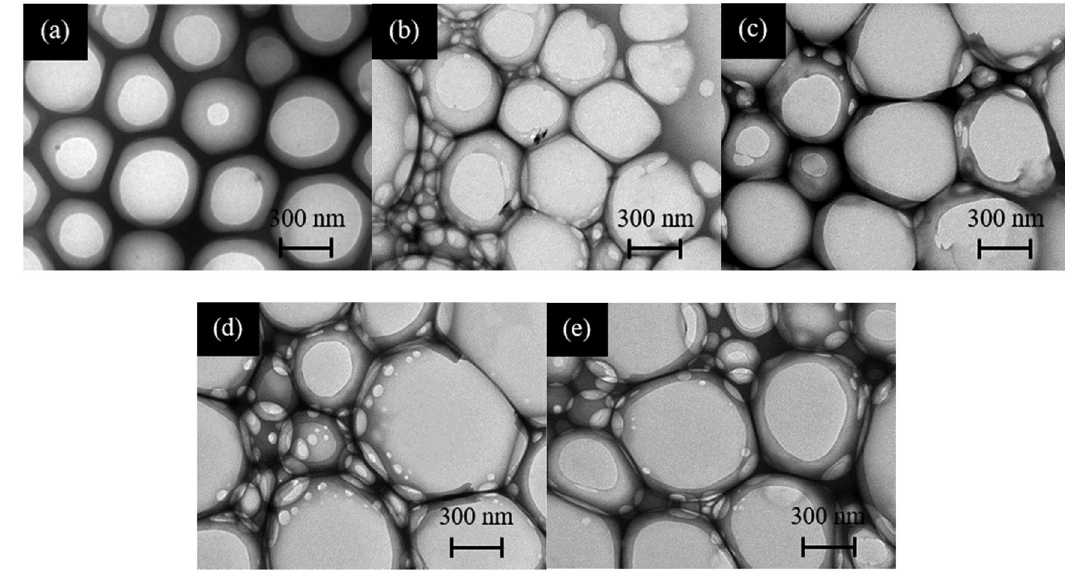
Figure 3: TEM photographs of BSA/AM microcapsules at di ff erent amplitudes: ( a ) 30%, ( b ) 40%, ( c ) 50%, ( d ) 60%, and ( e )